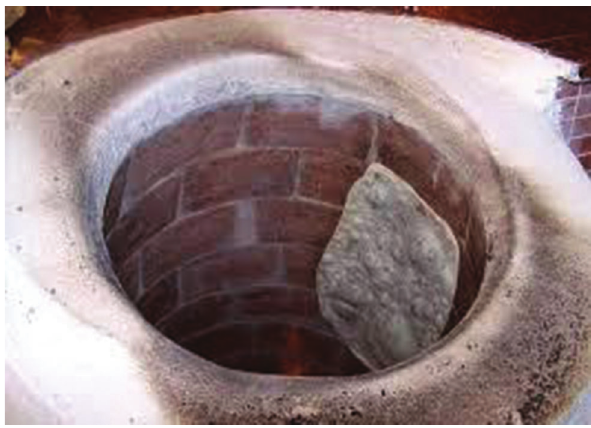
Figure 1 - Traditional large oven (Tandir).